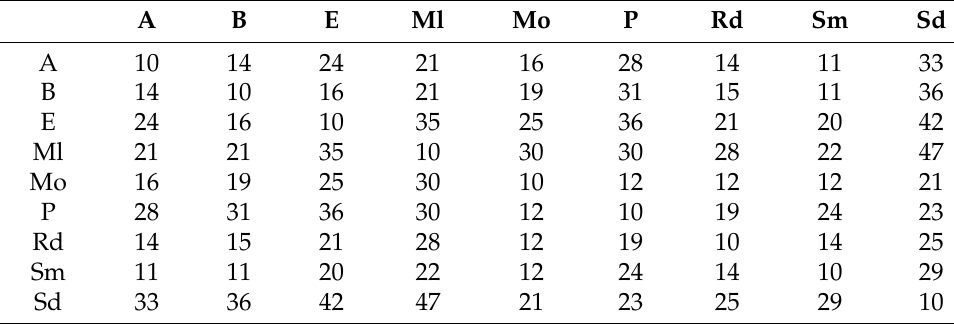
Table 5. Distance between locations (in